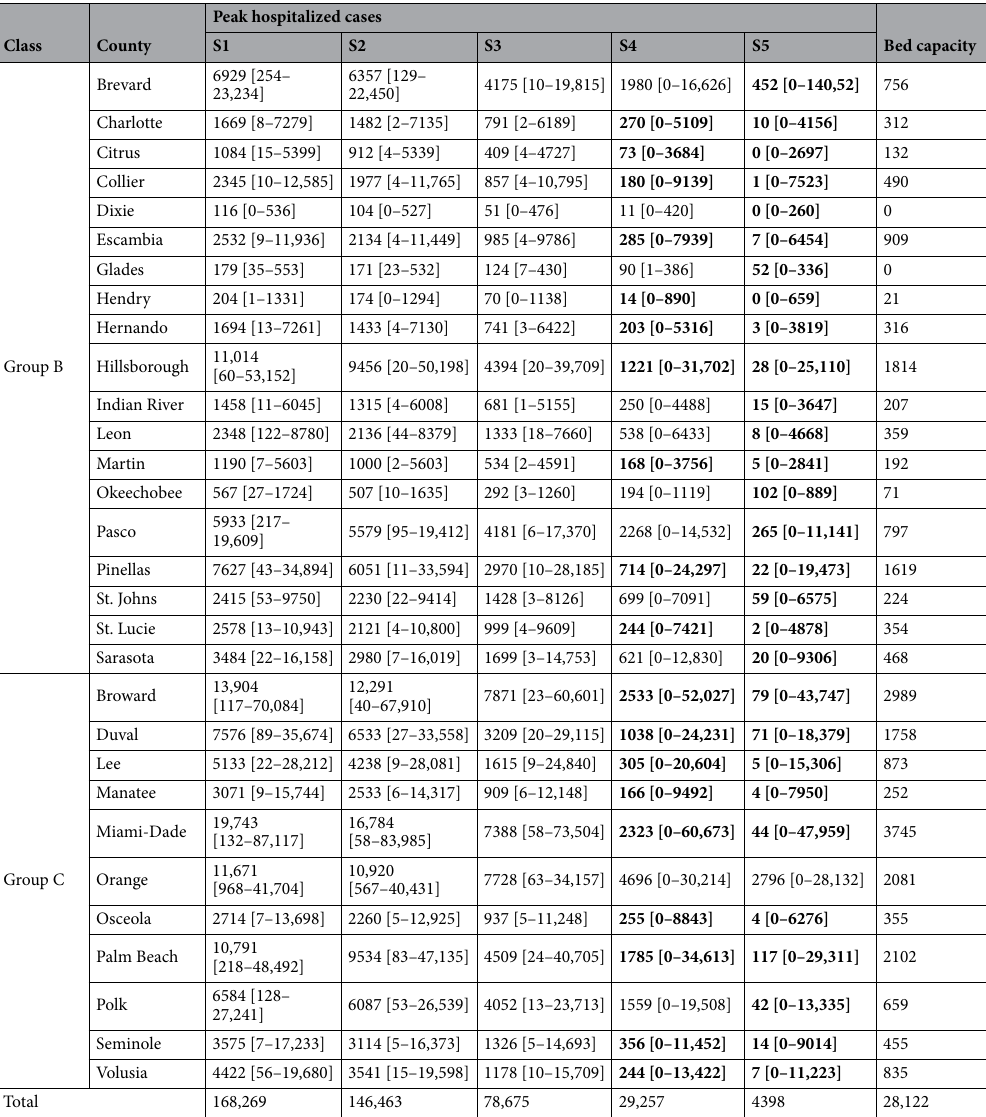
Table 2. Total hospitalized cases predicted at the epidemic peak in each county. The 90% confidence interval is given in brackets. Bold cells denote situations when hospitalization cases are predicted to be below